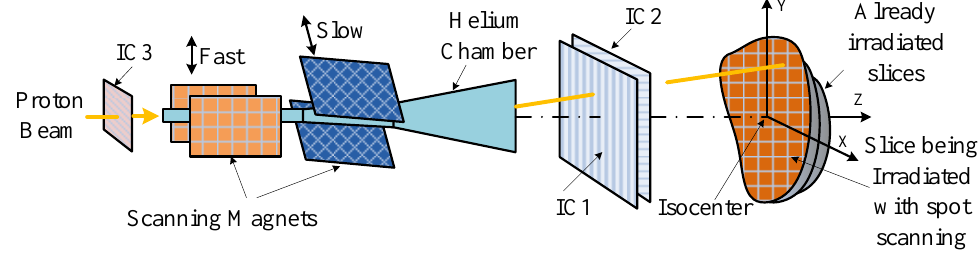
Figure 2. Nozzle layout principle.